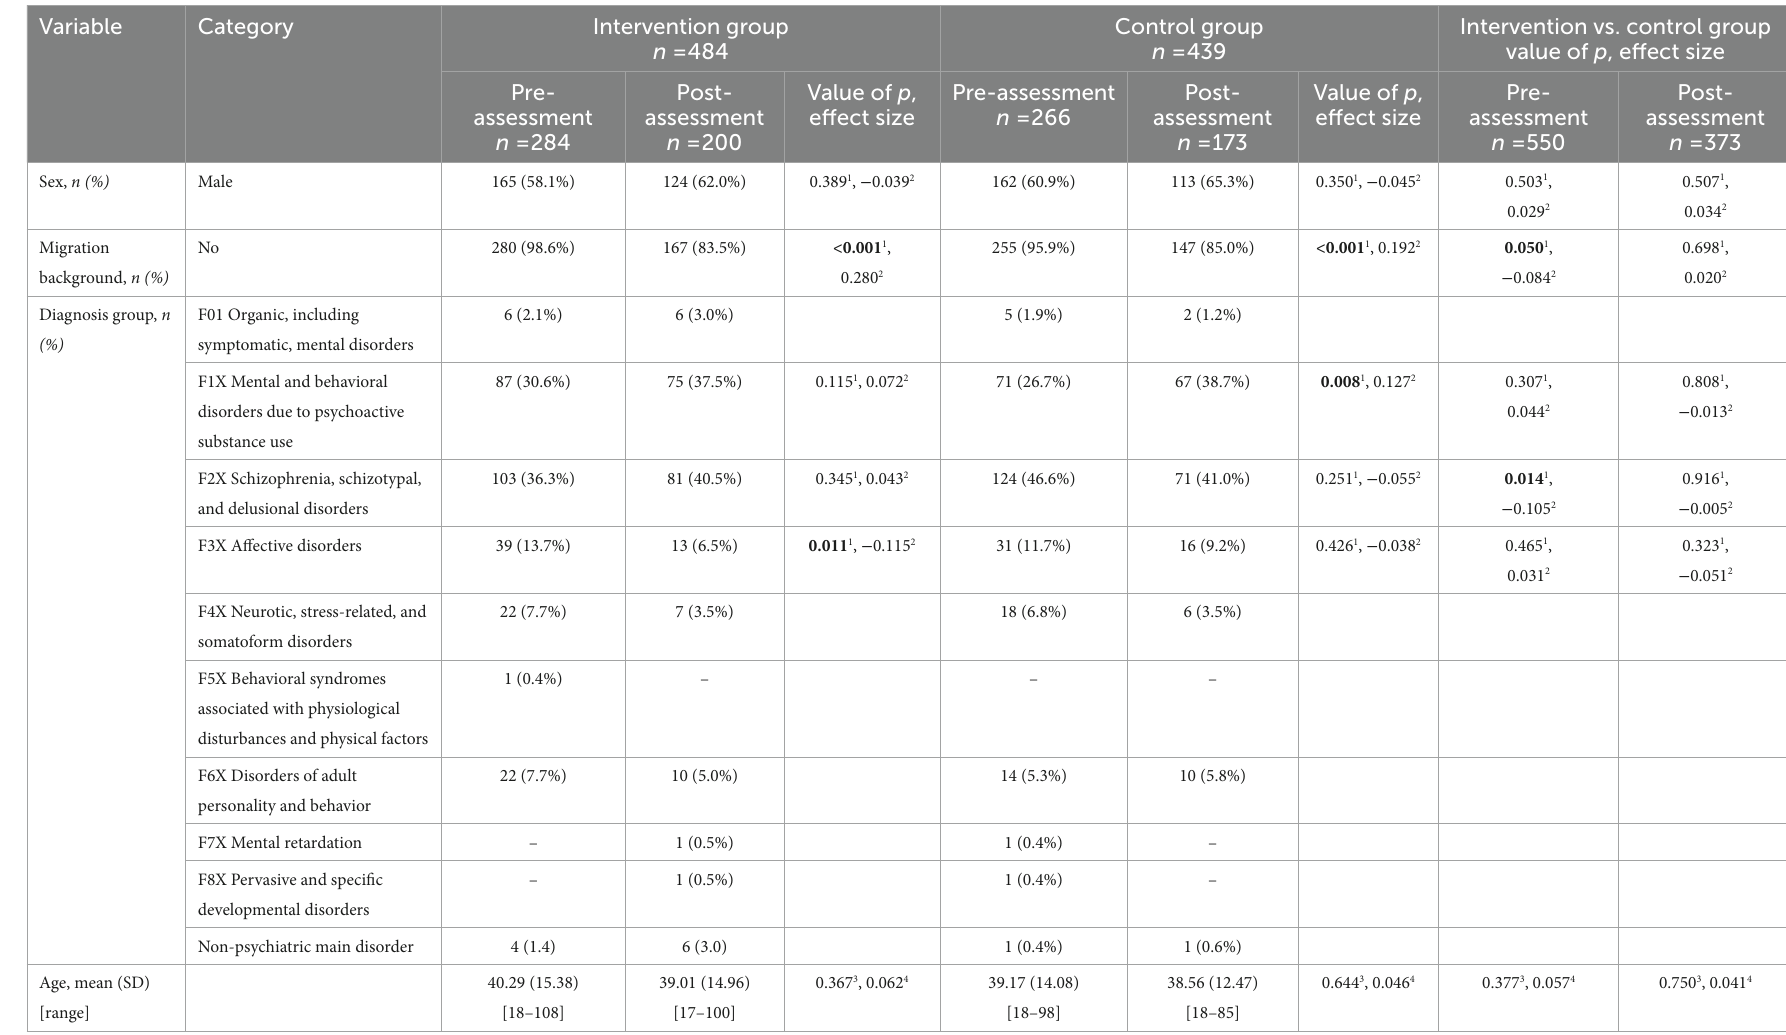
TABLE 1 Sociodemographic and disease-related data per group (IG or CG) with regard to all patients treated before (pre) and after (post) the implementation of peer support ( n =